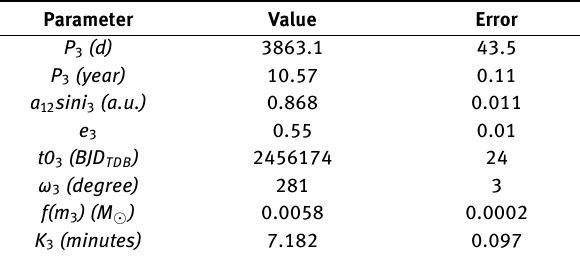
Table 4. Results from the O-C analysis of V1848